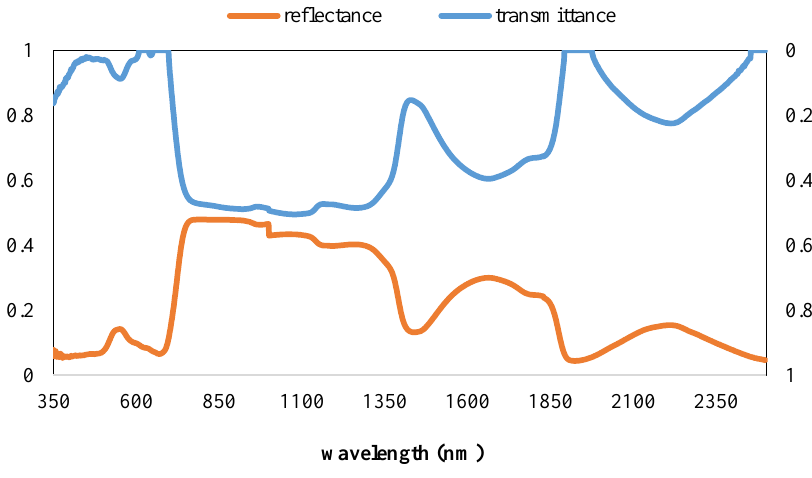
Figure 18. The measured reflectance and transmittance of maize